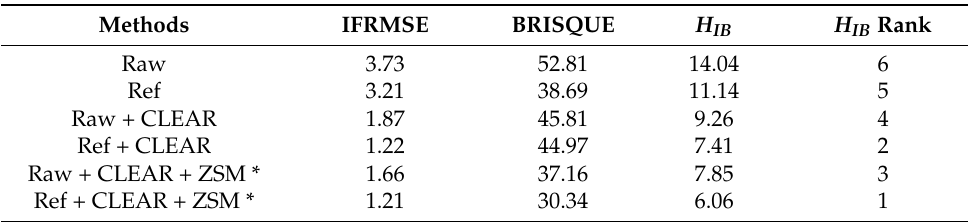
Figure 9. Method comparison of the ‘Building’ sequence. ( a ) Raw; ( b ) Raw+CLEAR; ( c ) Raw+CLEAR+ZSM; ( d ) Ref; ( e ) Ref+CLEAR; ( f ) Ref+CLEAR+ZSM; ( g ) Ground truth. Table 3. Comparison of different approaches using BRISQUE, inter-frame RMSE, and hybrid metrics for the ‘Chimney’